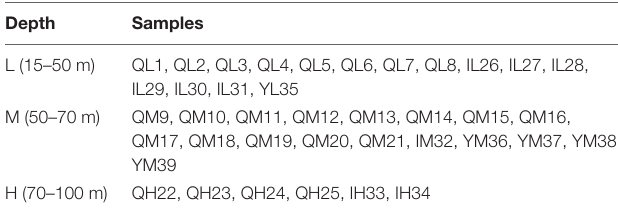
TABLE 3 | Samples from different